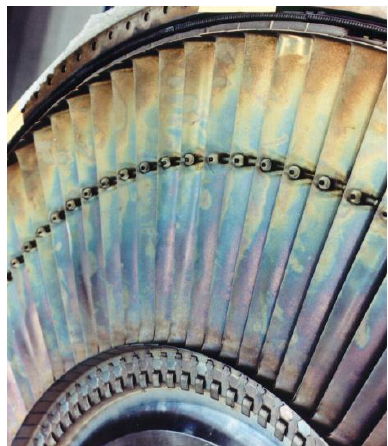
Figure 12. Image of the 747 class engine low-pressure turbine (LPT) rotor with Gamma alloy air foils after the demanding but successful factory test described earlier.